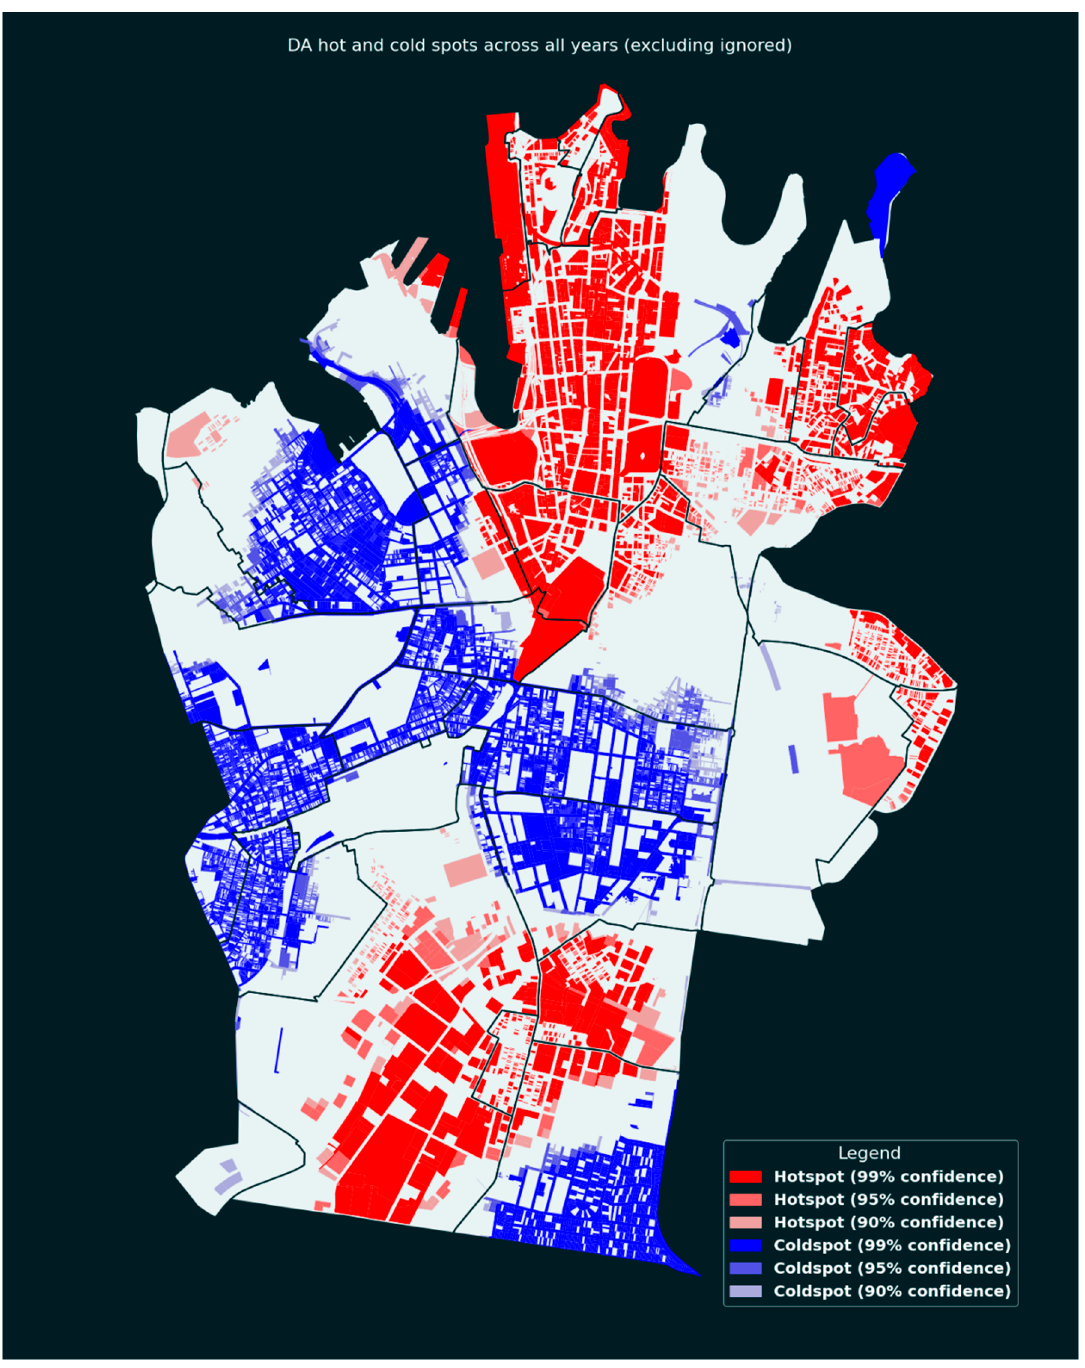
Figure 21. Development hot and cold spots across all years, excluding minor DAs (DAs categorised as ignored earlier) (2005–2021).